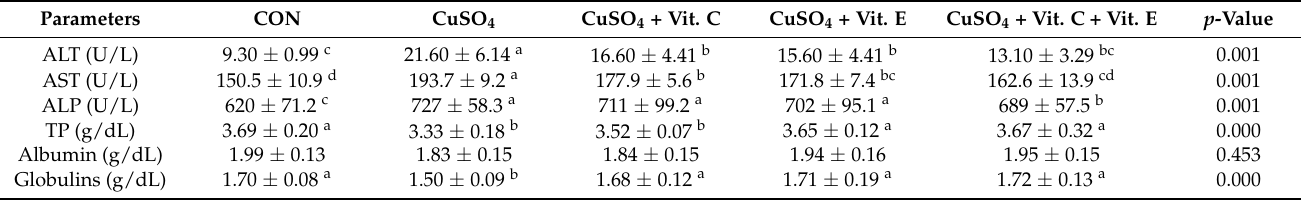
Table 3. Effect of single or combined supplementation of vitamin C and E on broiler chickens’ liver enzyme activities and protein profile at the end of the 3rd week (Mean ± SD, n = 5).